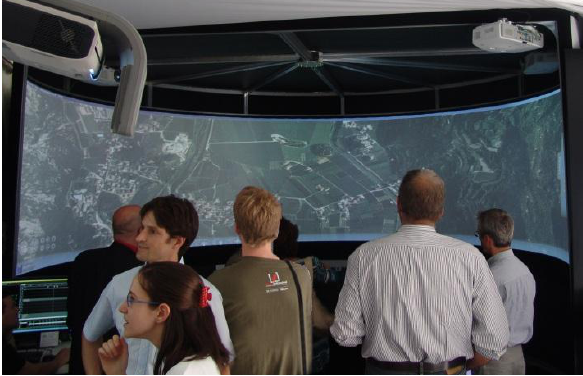
Figure 5: an image of the system being used during the Fair of Economics